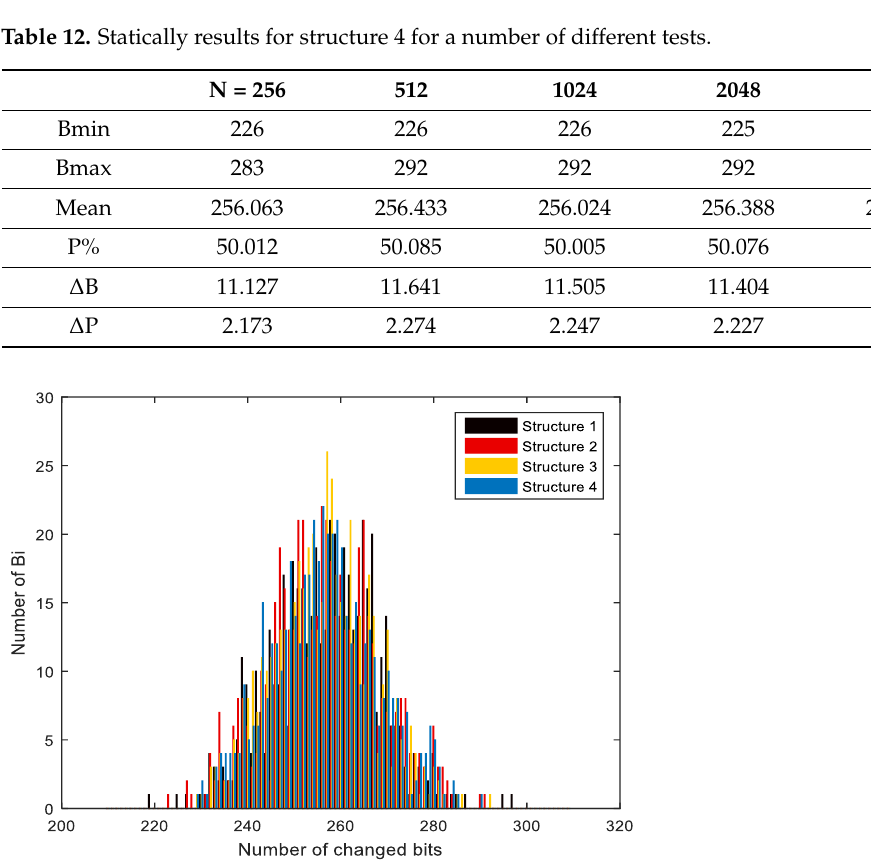
Figure 12. Results and histograms of the average number of changed bits. Table 8. Confusion and diffusion test results for 1000-message tests.